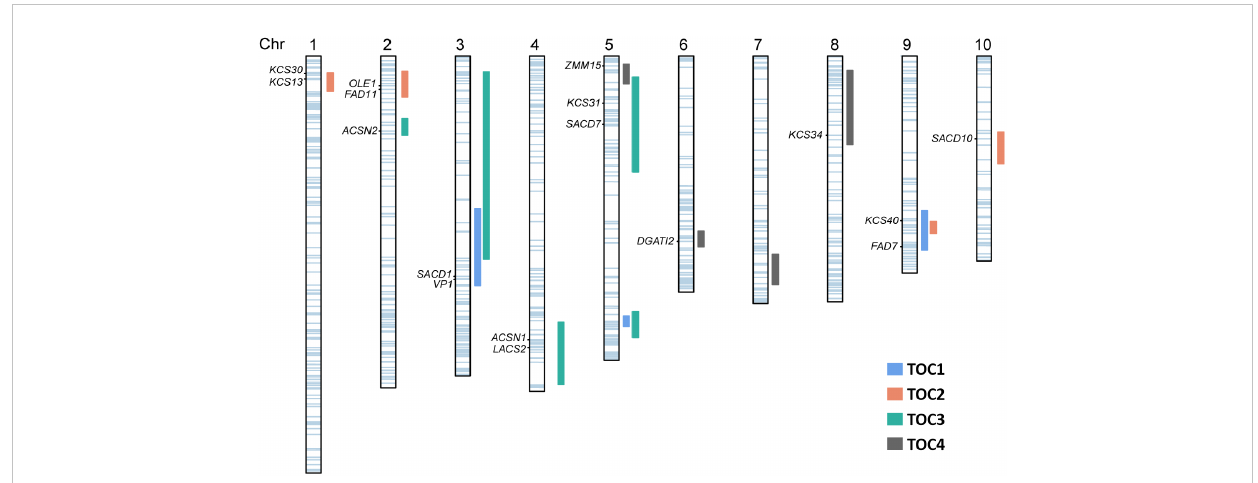
FIGURE 4 Association of candidate genes with kernel oil QTLs. The QTLs identi fi ed in four DH populations are represented as vertical rectangles of different colors next to each chromosome. The horizontal light blue bars on each chromosome show the positions of the 189 identi fi ed genes. The left labels denote known genes that co-localized with the